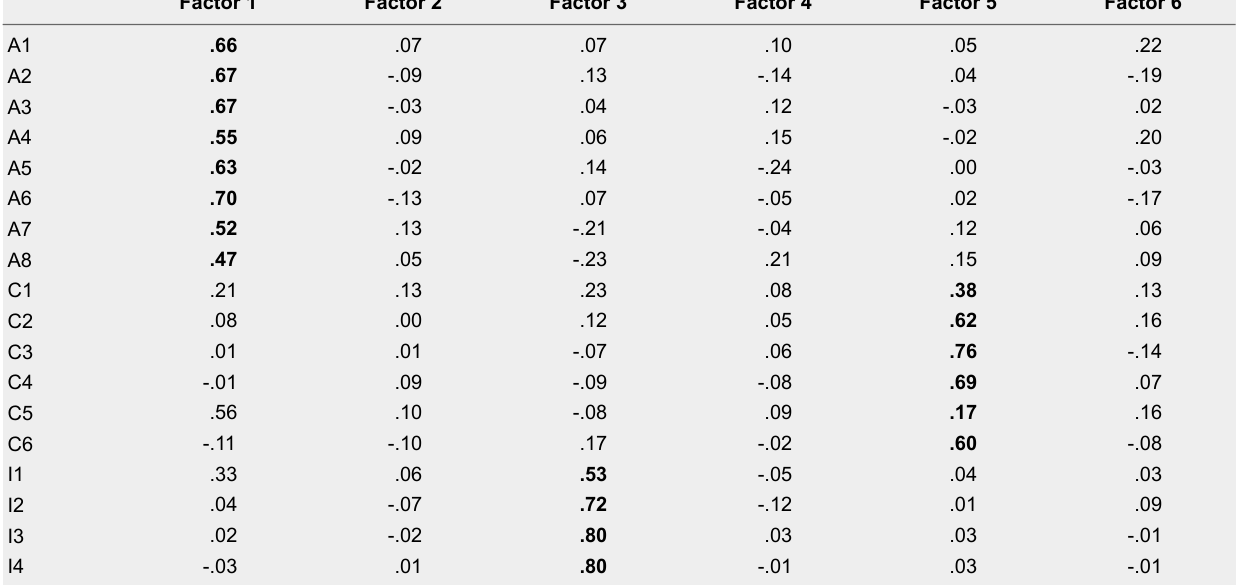
Observed Loadings in the Exploratory Six Factor